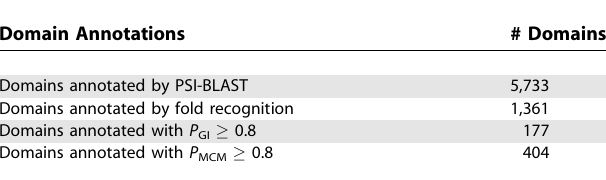
Table 2. Overview of Domain Annotations Using All Methods Employed in This Work